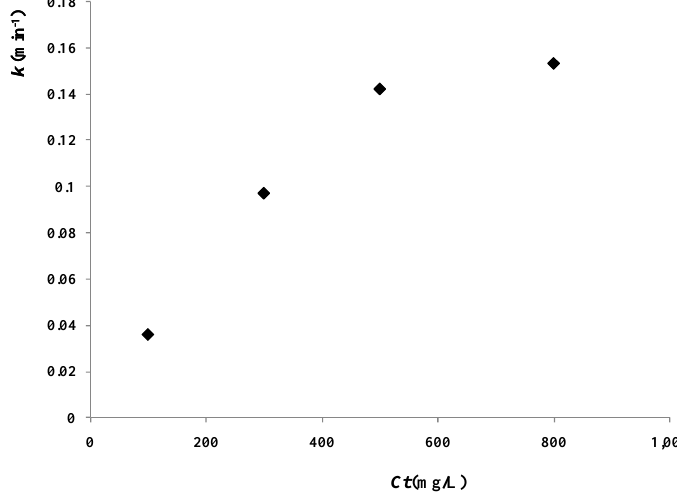
with different catalyst concentrations (reaction t = 20 mg/L, S = 400 W/m). 0 L